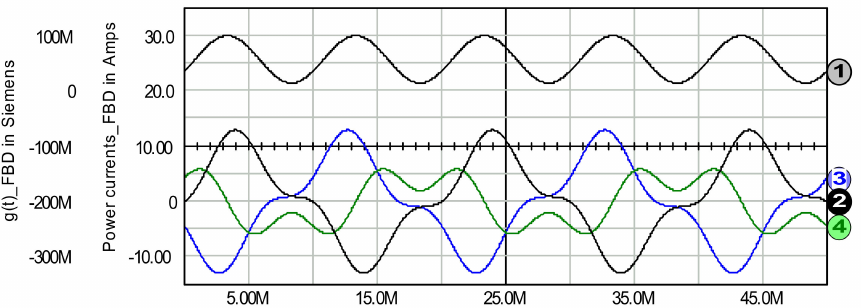
Figure 3. FBD theory approach. Conductance g D signal, waveform 1, and Depenbrock phase power currents, waveforms 2, 3, and 4 in phase A, B and C,